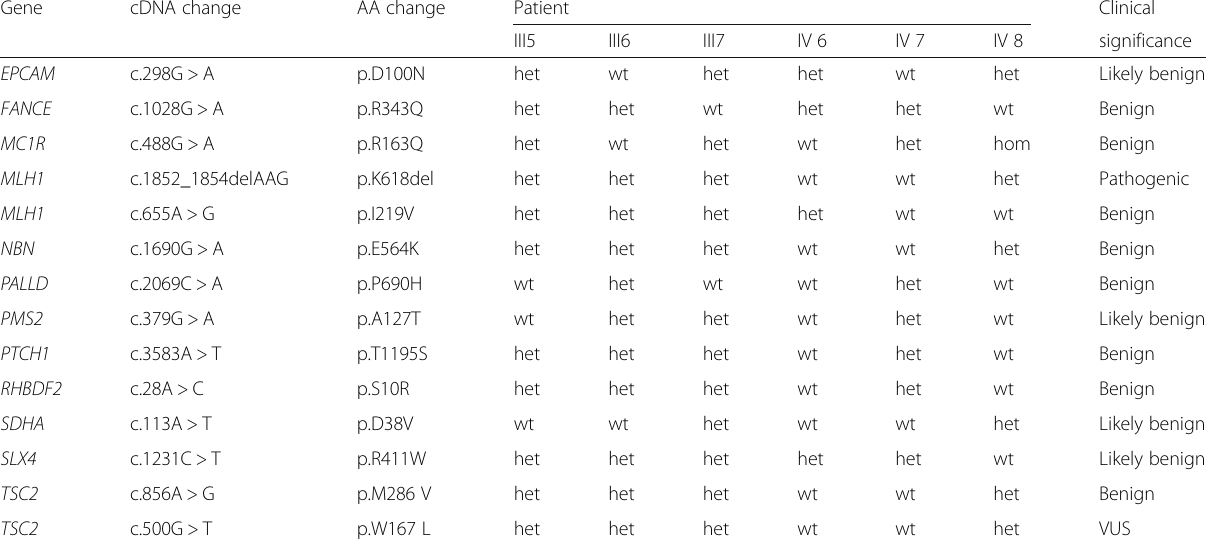
Table 1 Sequencing result on genes associated with hereditary cancer syndrome in family members Gene cDNA change AA